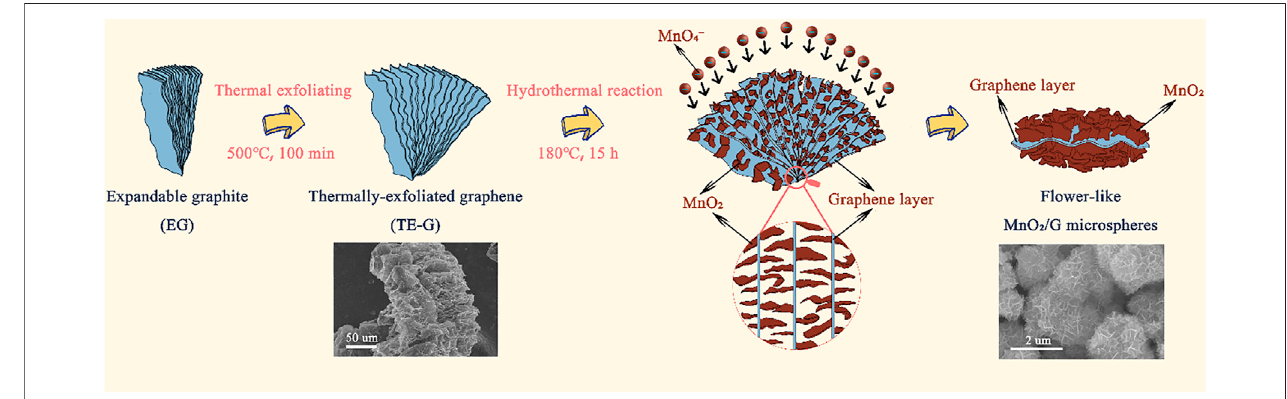
FIGURE 1 | Schematic presentation of the preparation of accordion structure TE-G and fl ower-like MnO 2 /G microspheres, and the inset SEM images presenting the morphology of TE-G and MnO 2 /G composites respectively.